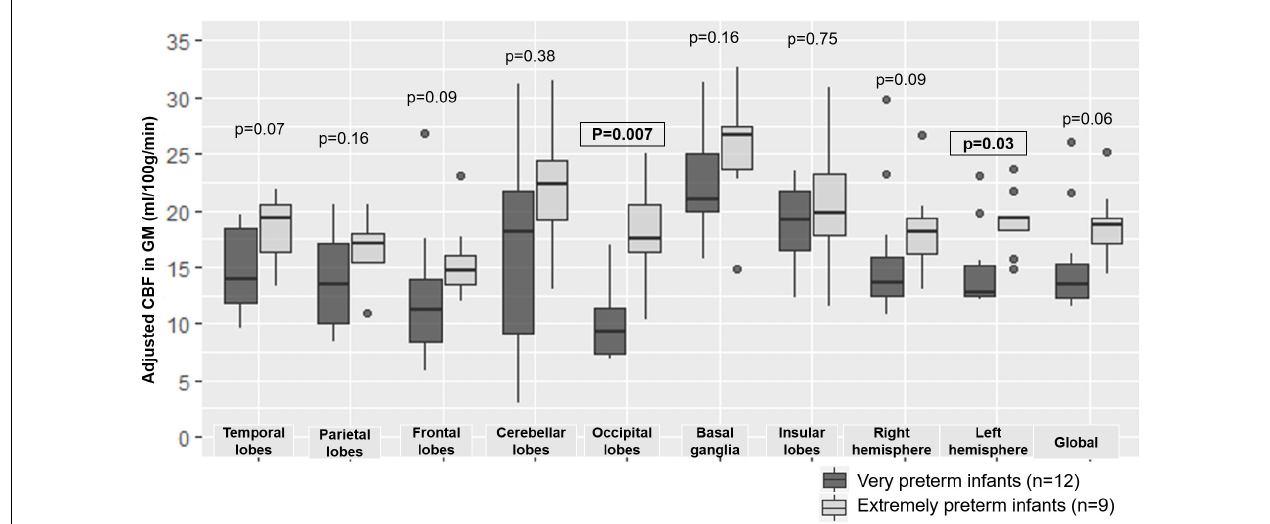
FIGURE 6 | Boxplot representing regional and overall CBF according to degree of prematurity. CBF: cerebral blood flow, GM: gray matter. The significant p -values are in bold characters within a square frame.